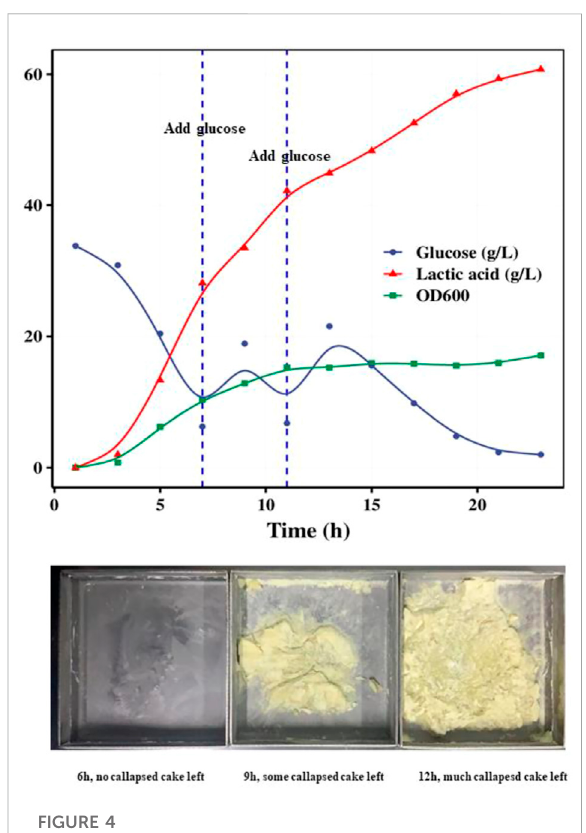
Carbon source utilization capacity of the strains tested in